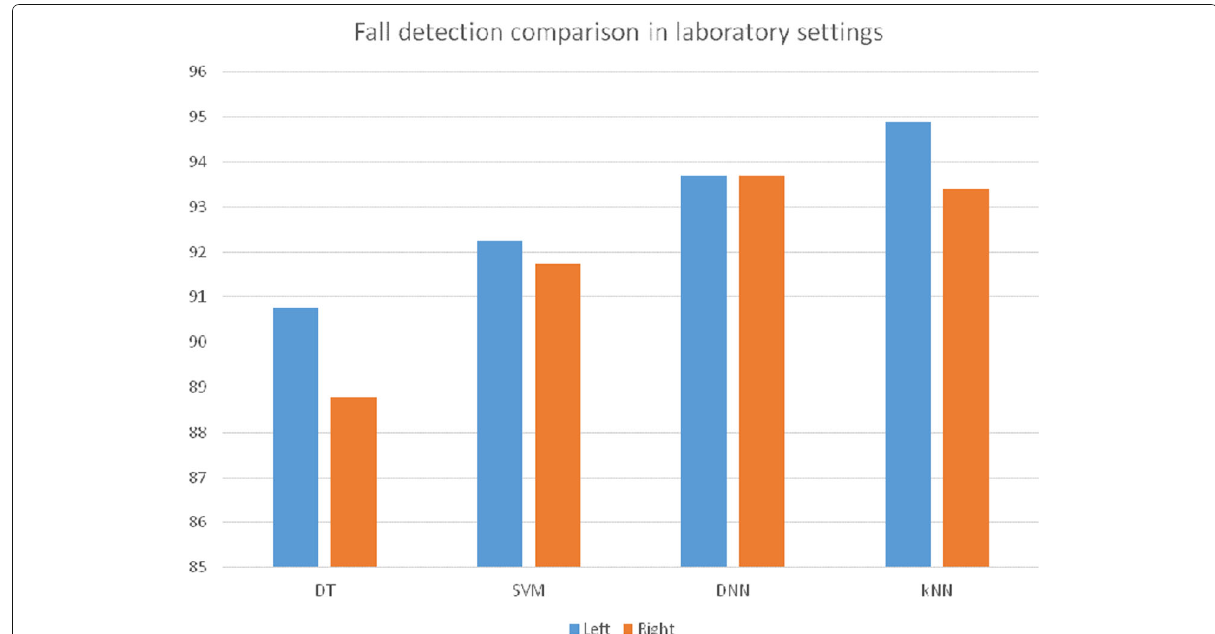
Fig. 4 Method comparison. There is a clear distinction between the left and right hands. kNN ( k = 5) performs best for the left hand (overall), closely followed by DNN with 4 fully connected